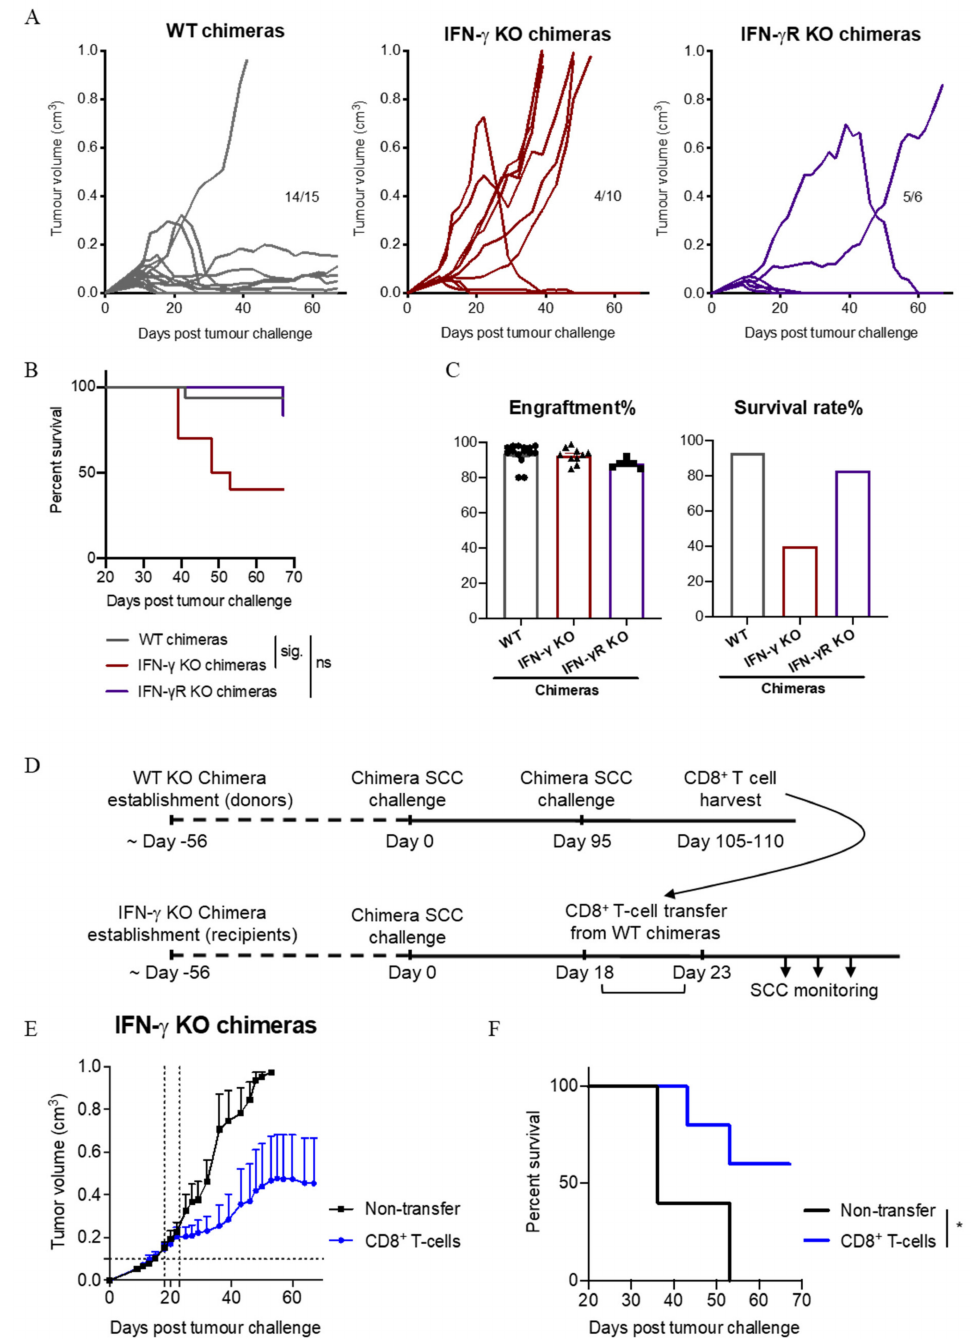
Figure 8. IFN- γ secretion by CD8 + T cells is important for SCC tumour control. ( A ) SCC establishment in individual chimeric mice. n = 15 WT, 10 IFN- γ − / − , and 6 IFN- γ R − / − . Data shown are combined from 4 independent experiments. Numbers in panels represent the proportion of mice alive at the end of the experiment. ( B ) Comparison of mouse survival in A. Survival analyses was performed by Log-rank (Mantel-Cox) test. Results then displayed as significant (sig.) or not significant (ns) after bonferroni-corrected multiple comparison test. Bonferroni-corrected threshold = 0.016, K = 3. ( C ) Bone marrow engraftment efficiency and survival percentage in A. Data points represent individual mice. ( D ) Experimental schedule for CD8 + T cell transfer experiments into tumour-bearing IFN- γ KO chimeras. ( E ) Growth of established SCC tumours before and after CD8 + T cell transfer. T cells were transferred when individual tumours reached 0.1 cm 3 (indicated by horizontal dotted line), which occurred between days 18 and 23 (represented by vertical dotted lines). Data shown combined from 2 independent experiments, mean ± SEM, n = 5/group. ( F ) Comparison of mouse survival in E. Survival analysis was performed by Log-rank (Mantel-Cox) test. *, p <